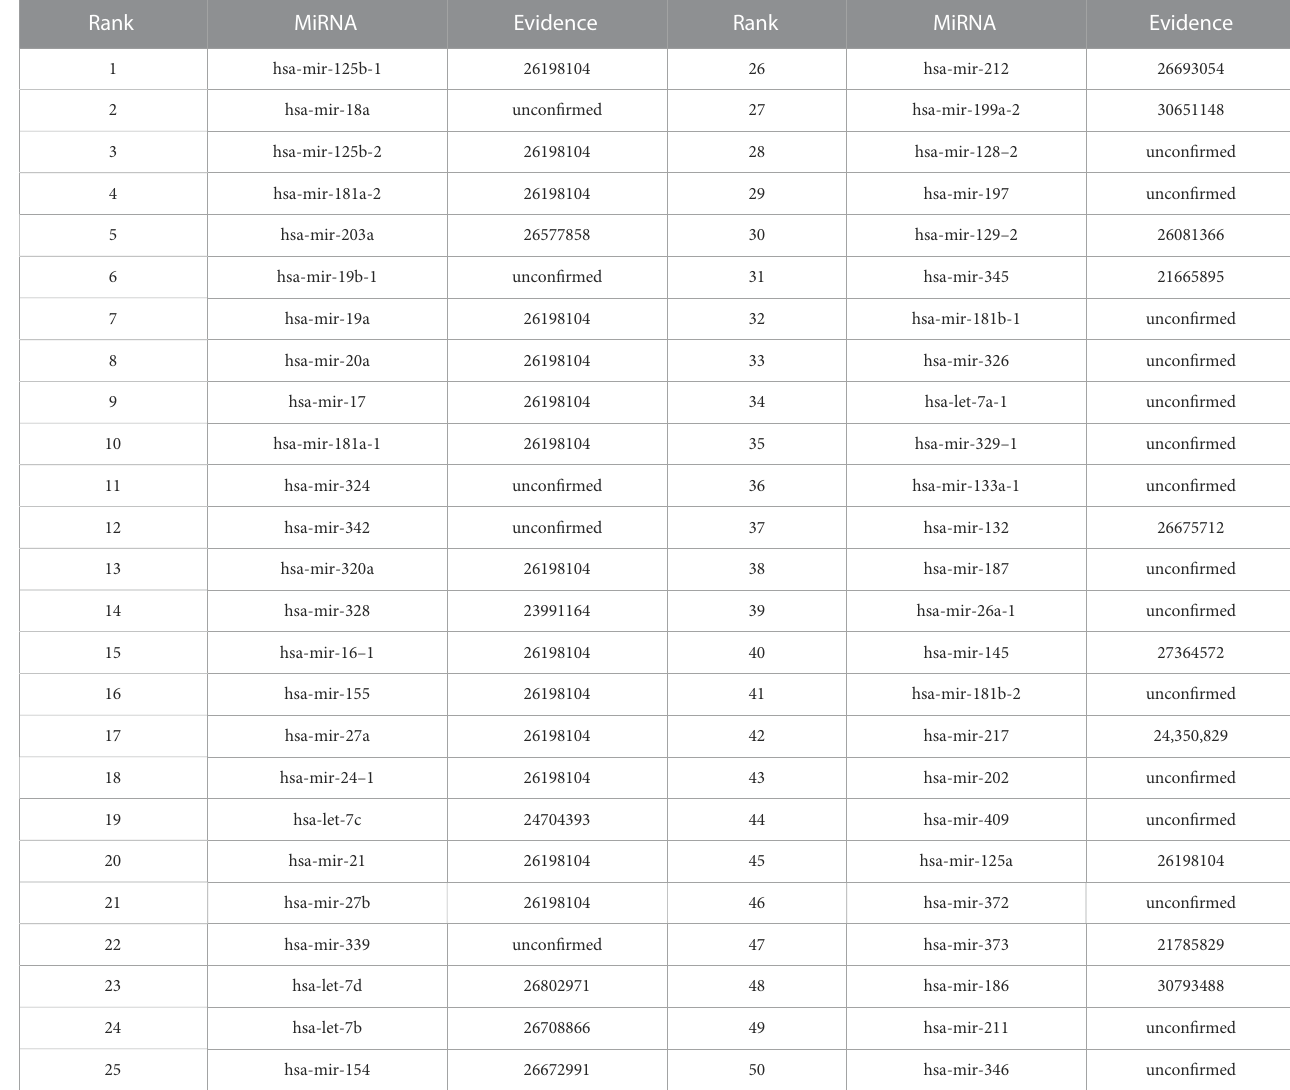
TABLE 4 The top-50 miRNAs related to 5-Aza-CdR are predicted by GNMFDMA.